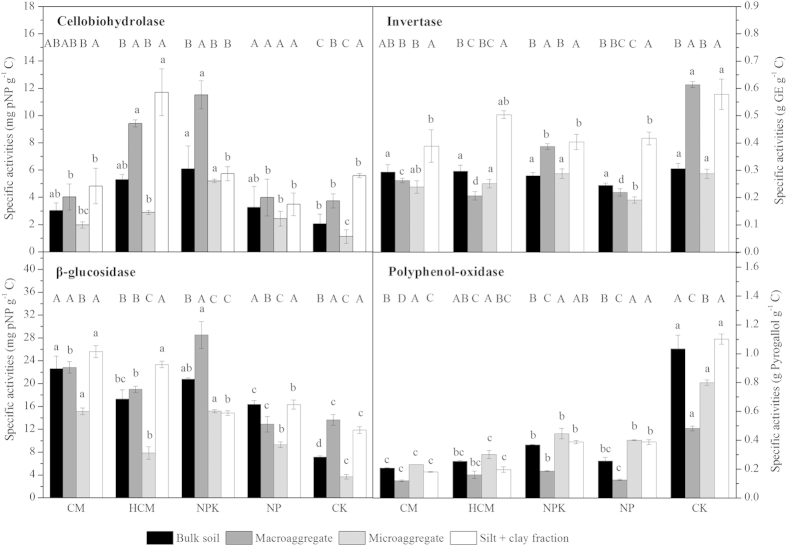
Specific activities of cellobiohydrolase, β-glucosidase, invertase (activity divided by the sum of O-alkyl C and di-O-alkyl C contents) and polyphenol-oxidase (activity divided by the sum of methoxyl/N-alkyl C and phenolic C contents) in bulk soils and aggregates.Different lowercase letters indicate significant differences between treatments for the same aggregate, and different capital letters indicate significant differences between aggregates for the same treatment (Tukey’s test, P < 0.05, n = 4).